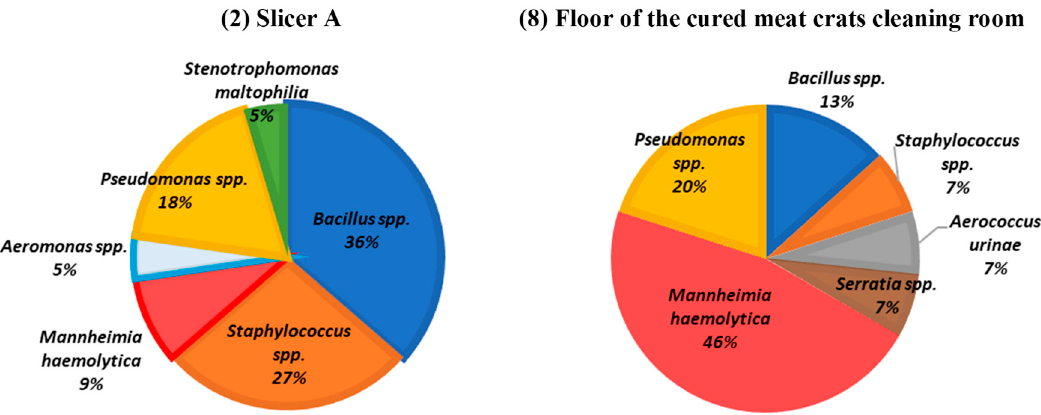
Figure 5. Individual profiles of the categorized areas, such as cluster 3, (8) cured meat carts cleaning room floor, and cluster 4, (2) slicer A.